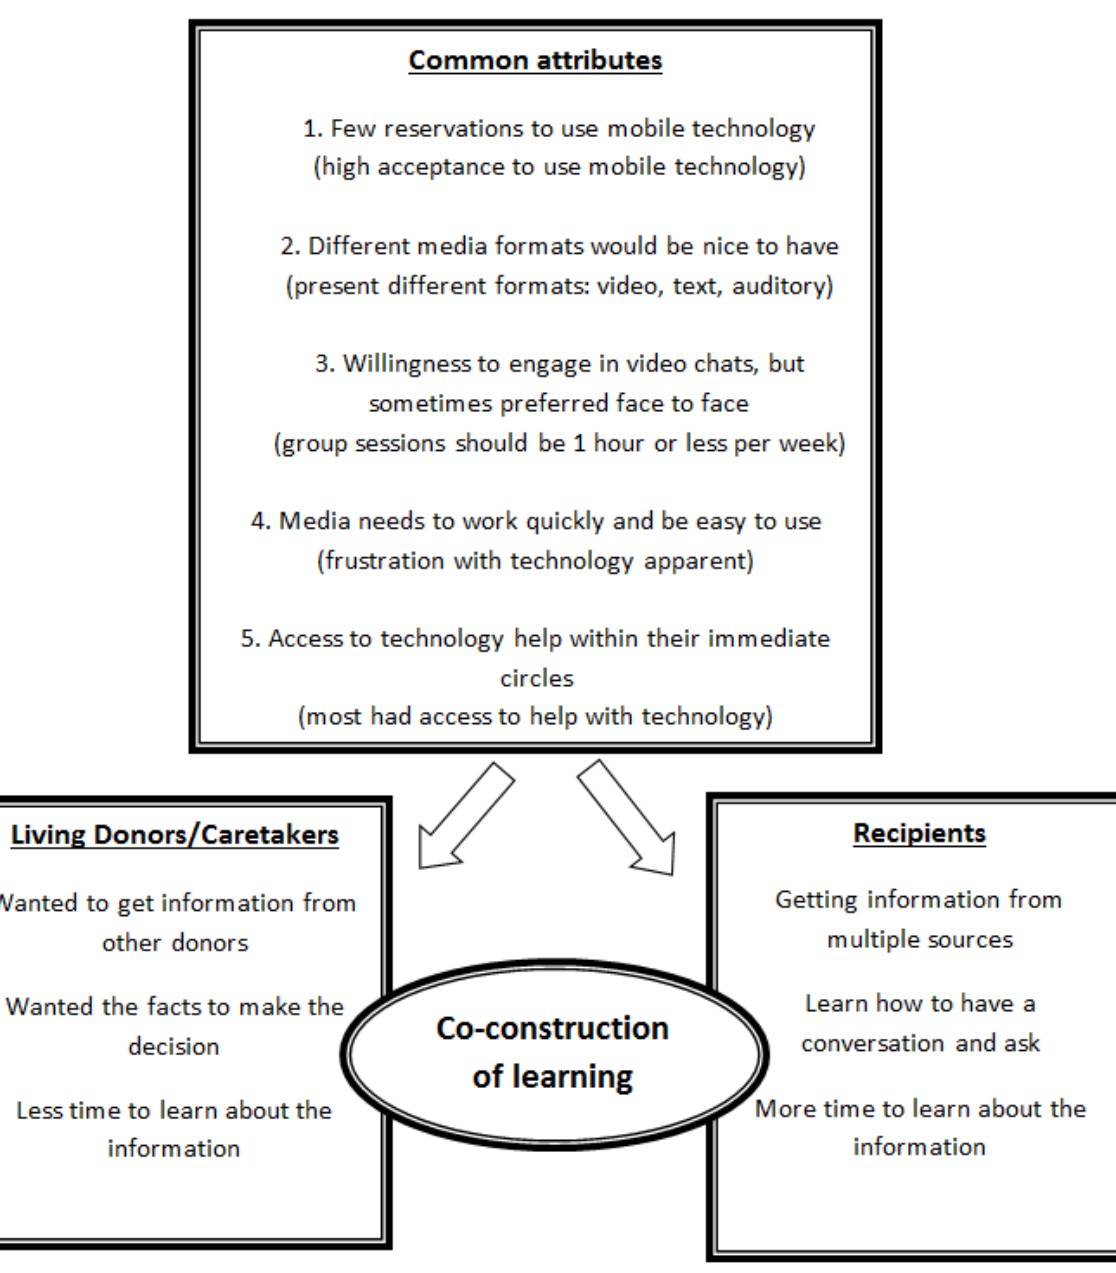
Figure 1. Similarities and differences between kidney transplant donors/potential donors and transplant recipients in mHealth-based preferences in learning about living kidney donor